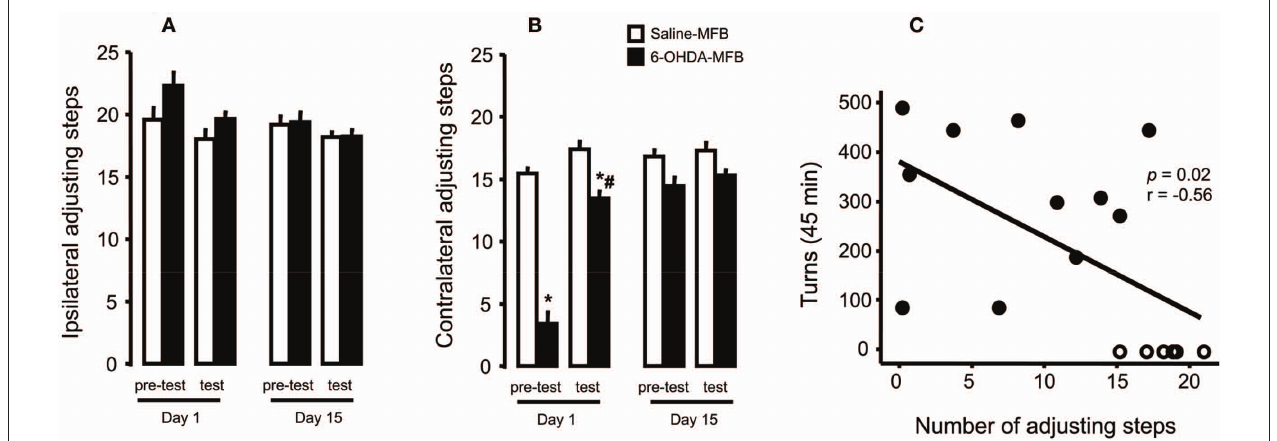
treatment also improved the akinesia in the contralateral paw until the end of the treatment (day 15). (C) Spearman correlation between contralateral